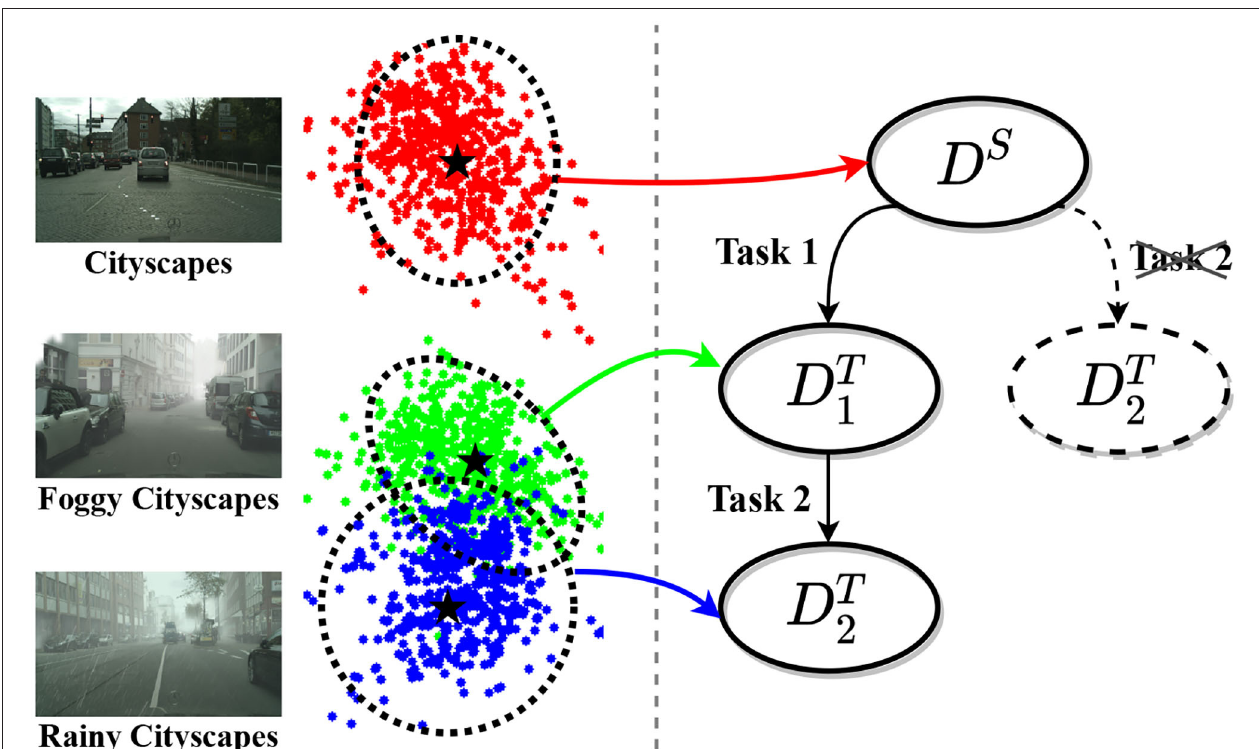
FIGURE 3 | Left: Visualization of data distributions of Cityscapes (Cordts et al., 2016), Foggy-Cityscapes (Sakaridis et al., 2018), and Rainy-Cityscapes (Hu et al., 2019), indicated by red, green, and blue dots, respectively. Right: Illustration of Domain